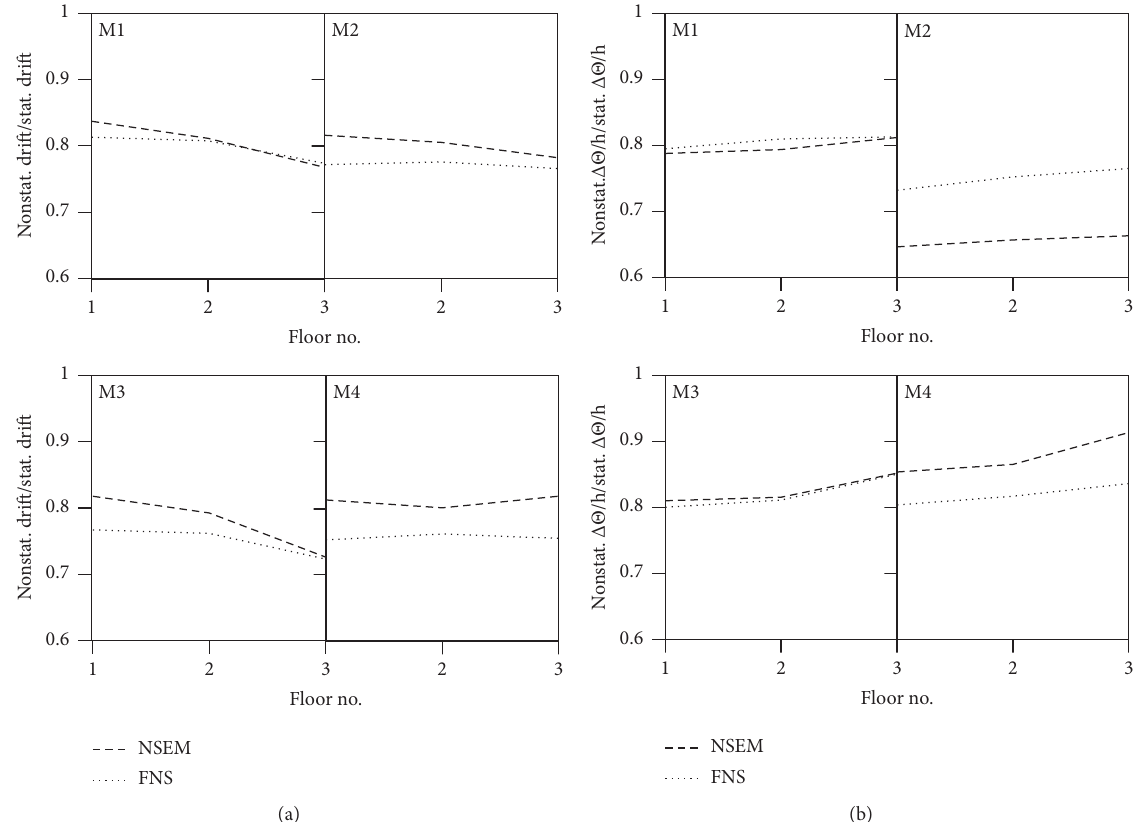
Figure 7: Ratios of variation of the average nonstationary interstorey drift (a) and relative torsion (b) demands with respect to the stationary ones for the considered models at the different